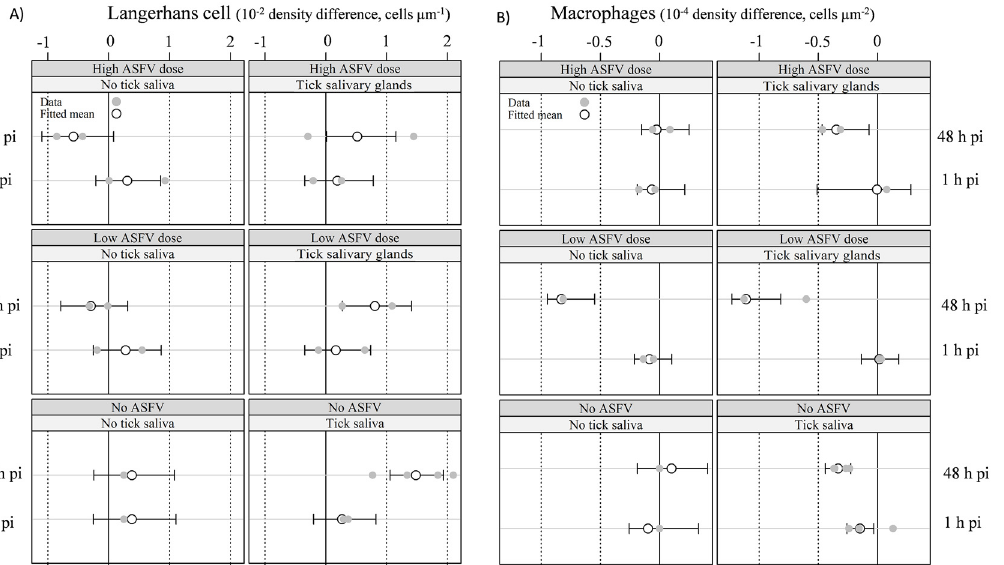
Fig 4. Pattern of immunological cell density difference between inoculated ear and opposite ear. (A) Langerhans cell density difference 10 − 2 x density difference, μ m -1 . (B) Macrophage density difference 10 − 4 x density difference, μ m -2 . The mean was fitted with a robust linear